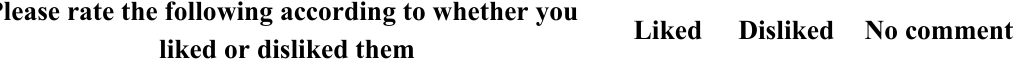
Table 5. Nutrition program survey response data (N =